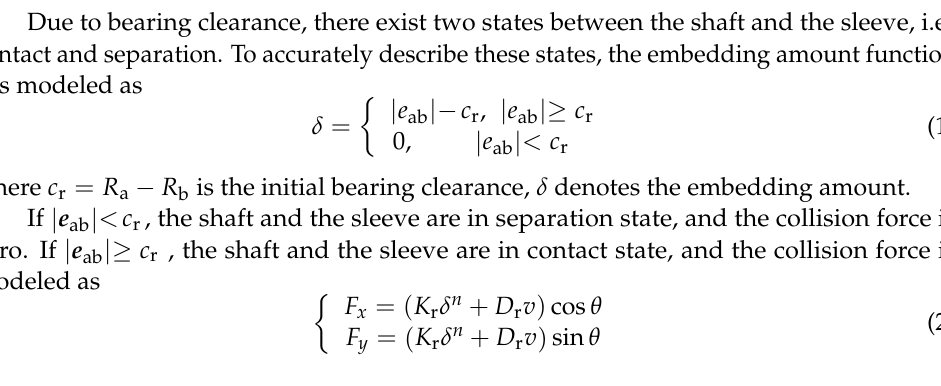
Figure 2. Geometrical relationship between a shaft and a